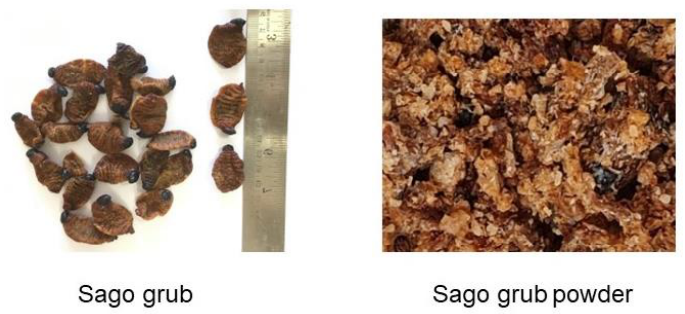
Figure 1. Representative images of sago grub and sago grub